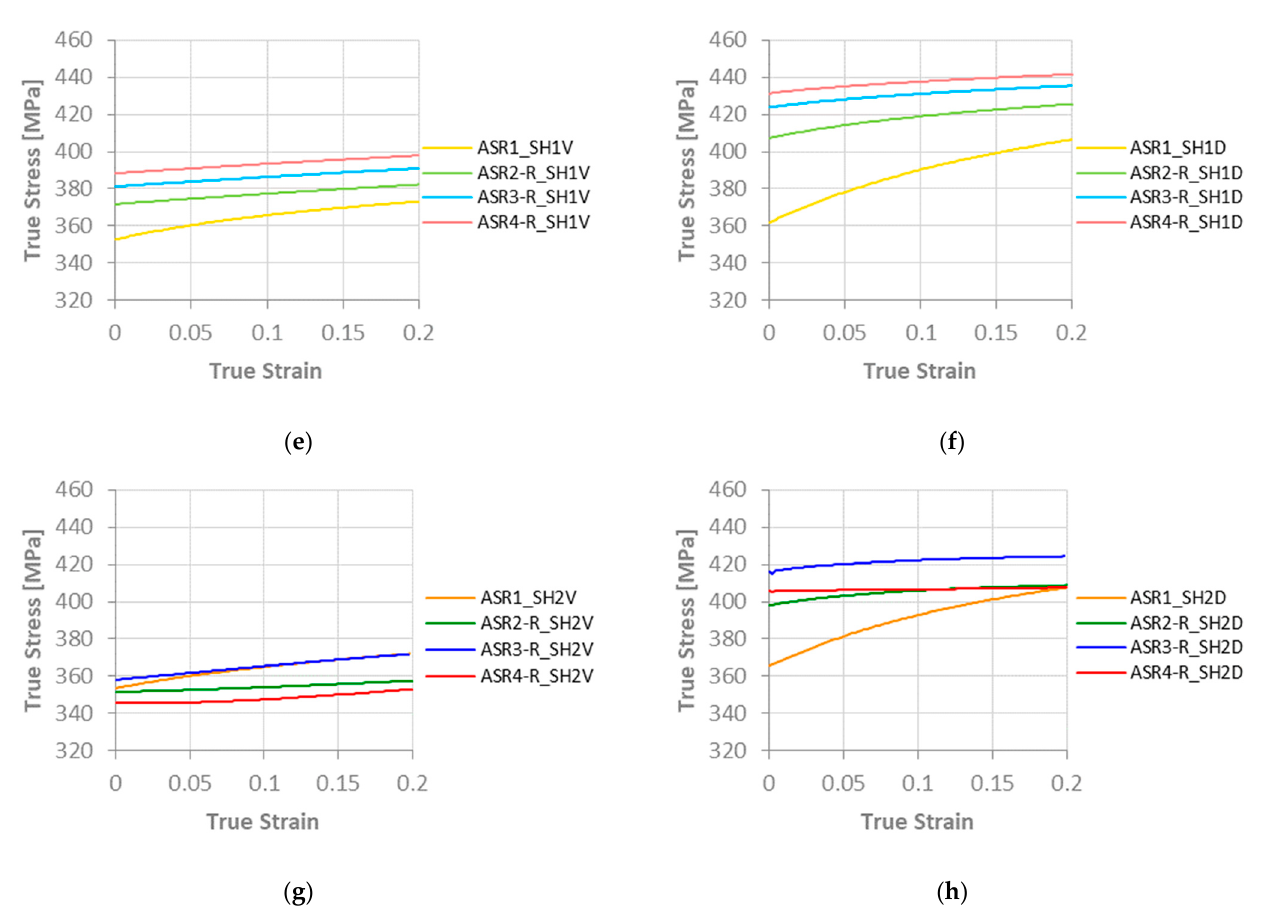
Figure 6. Stress–strain curves of four-pass sequences rolling with 20% reduction per pass, consider- ing two different shear strain values, (SH1) and (SH2), for simulations: ( a ) conventional rolling with a Voce-type hardening law (V); ( b ) conventional rolling with DDR model (D); ( c ) asymmetric roll- ing-continuous with a Voce-type hardening law; ( d ) asymmetric-continuous rolling with DDR model; ( e ) asymmetric-reverse rolling with a Voce-type hardening law and a lower shear strain value (SH1); ( f ) asymmetric rolling-reverse with DDR model and a lower shear strain value (SH1); ( g ) asymmetric-reverse rolling with a Voce-type hardening law and a higher shear strain value (SH2); and ( h ) asymmetric rolling-reverse with DDR model and a higher shear strain value (SH2).